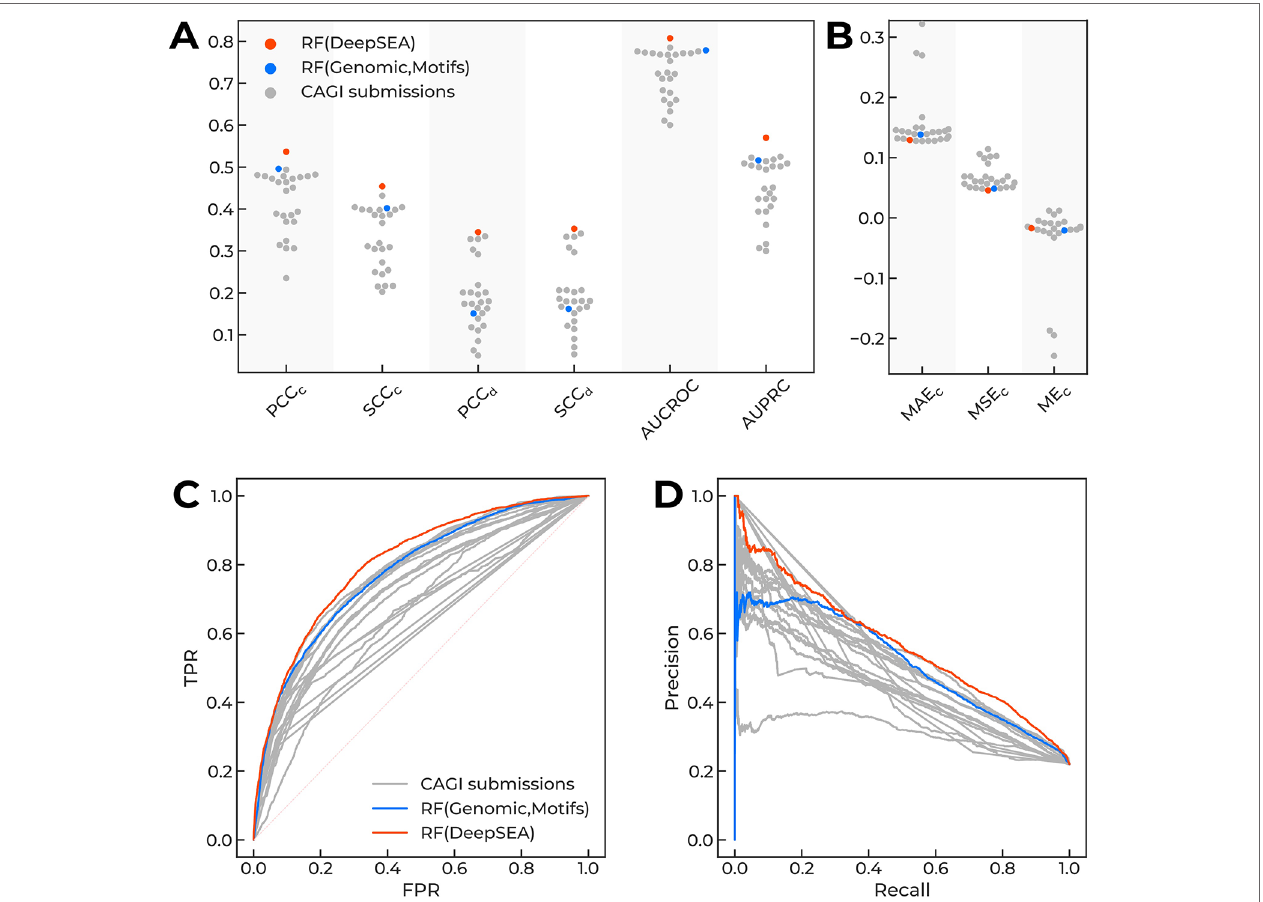
fiGURe 2 | The performance of different models predicting regulatory single-nucleotide variant (SNVs) of the CAGI “Regulation Saturation” challenge. Orange dots, Random Forest classifier using DeepSEA features. Blue dots, Random Forest classifier using features based on genomic data and sequence motif analysis. Grey dots, CAGI challenge submissions. (A , B) Different performance measures for prediction of expression direction (d) and confidence scores (c): Pearson (PCC c and PCC d ) and Spearman (SCC c and SCC d ) correlation coefficients, area under curve for receiver operating characteristic (AUCROC), area under precision-recall curve (AUPRC), mean absolute error (MAE c ), mean squared error (MSE c ), and mean error (ME c ). (C , D) Receiver operating characteristics and precision-recall